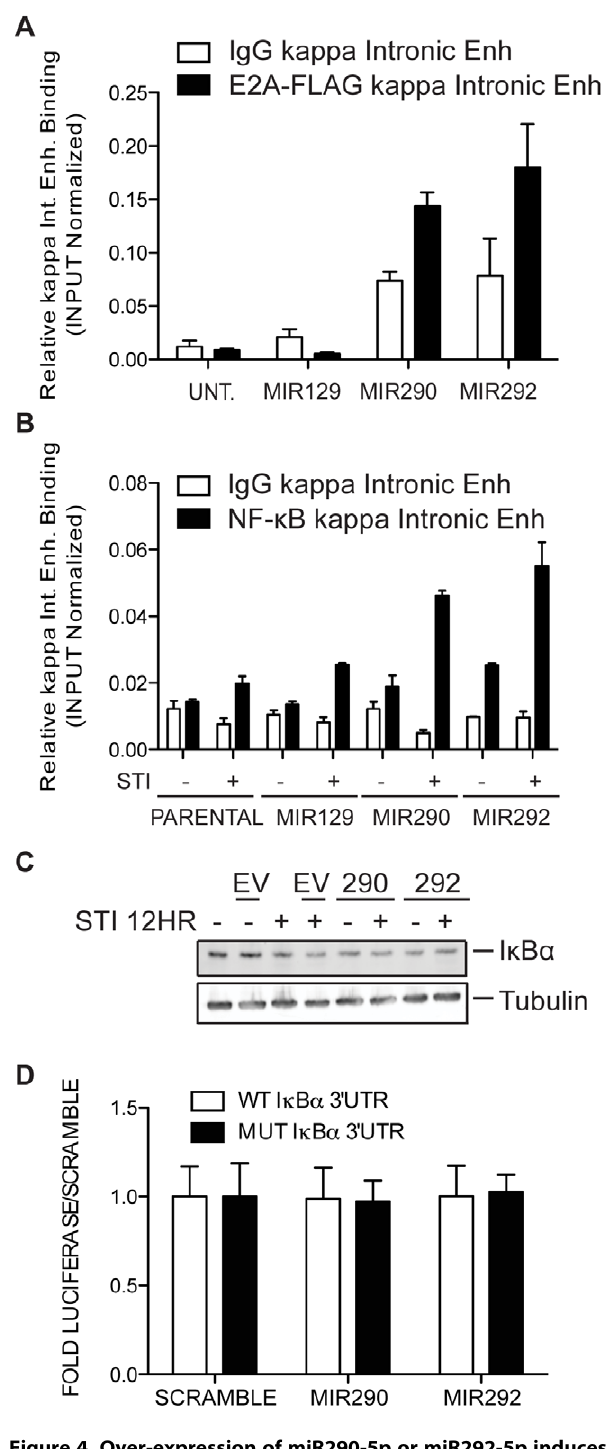
Figure 4. Over-expression of miR290-5p or miR292-5p induces activation of E2A and NF- k B. 4A. ChIP analysis of HF4 AMuLV cells expressing His-FLAG-E2A, at endogenous levels, and over-expressing either miR129-2_3p, miR290-5p, or mir292-5p. Chromatin samples were immunoprecipitated with anti-FLAG or IgG control antibody. Relative enrichment of bound DNA over input was determined by subjecting precipitates to qPCR with primers specific to the E k i binding region for E2A. This data shows one representative experiment of two indepen- dent experiments. 4B. ChIP analysis of E2A + / + AMuLV cells over- expressing either miR129-2_3p, miR290-5p, or mir292-5p, in the absence or presence of STI571 (1 m M, 16 hr). Chromatin samples